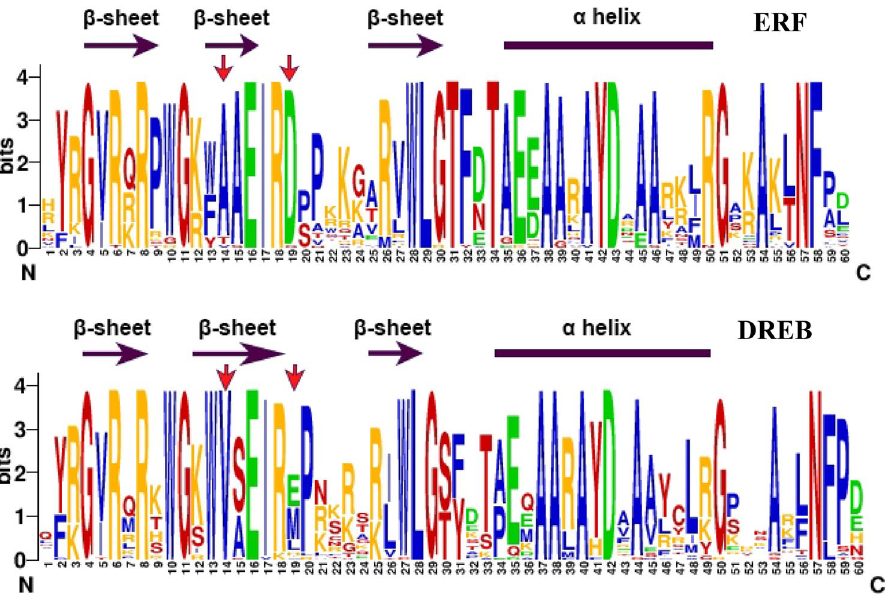
Figure 2. Sequence logo of AP2/ERF domains extracted from ERF and DREB protein sequences information. The β-sheets and α-helix were marked using purple arrows and boxes respectively. Specific conservated aa residues in the second β-sheet from ERF and DREB protein sequences were marked by red